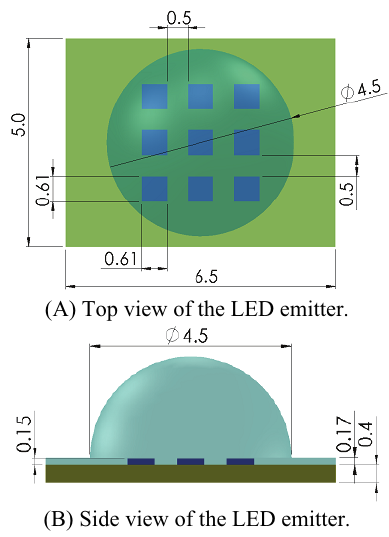
Fig. 5. Major geometric parameters of the LED emitter used in this study.